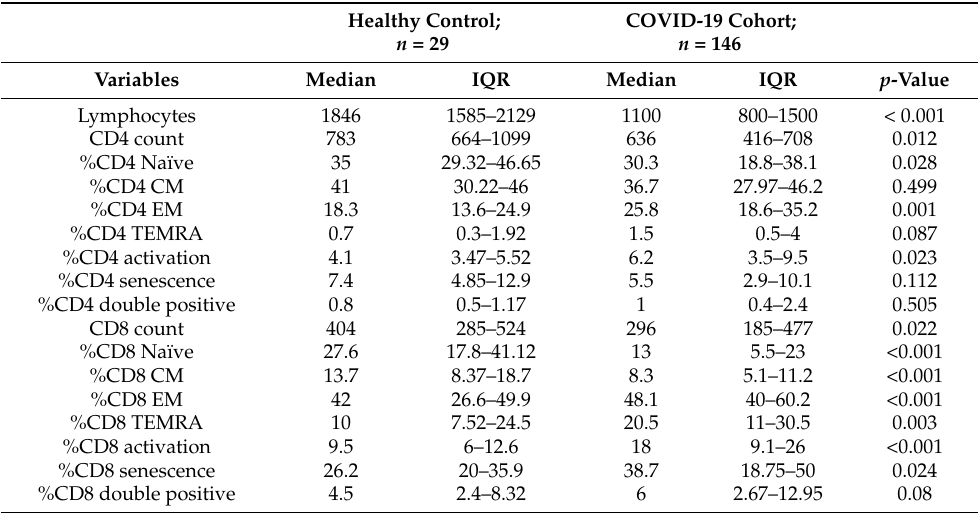
Table 2. Differential T phenotype between healthy controls and COVID-19